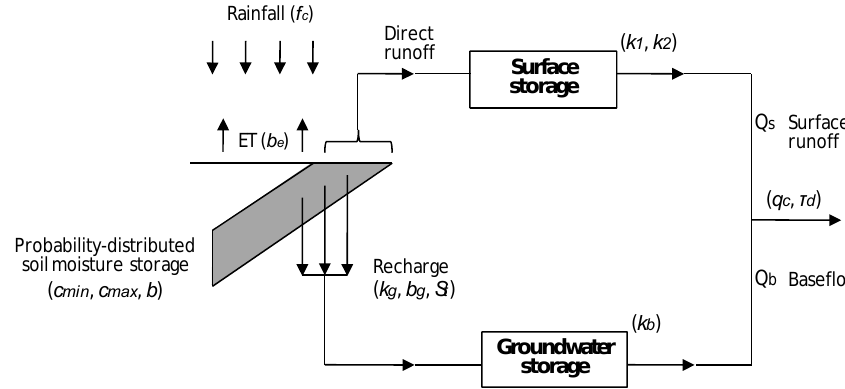
Table 1. Frequency bands of the wavelet decomposition levels for data with a sampling interval of 15min. Figure 2 Process of the discrete wavelet decomposition following the Mallat decomposition algorithm. X [ n ] is a discrete signal with n samples, passing though a low-pass filter G and a high-pass filter H with impulse responses of G [ n ] and H [ n ], respectively. A1 , A2 , A3 and D1 , D2 , D3 are the decomposed approximations and details on level j = 1, 2, 3….